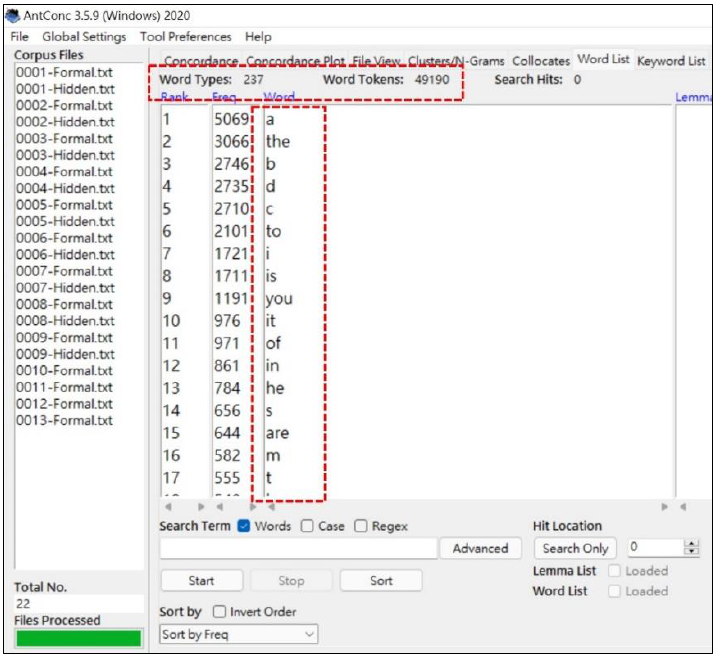
Figure 6. The function words that exist on the target corpus.